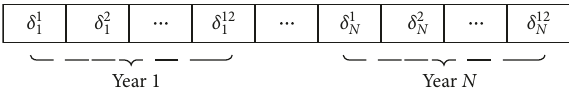
Figure 5: Chromosome representation of budget distribution.